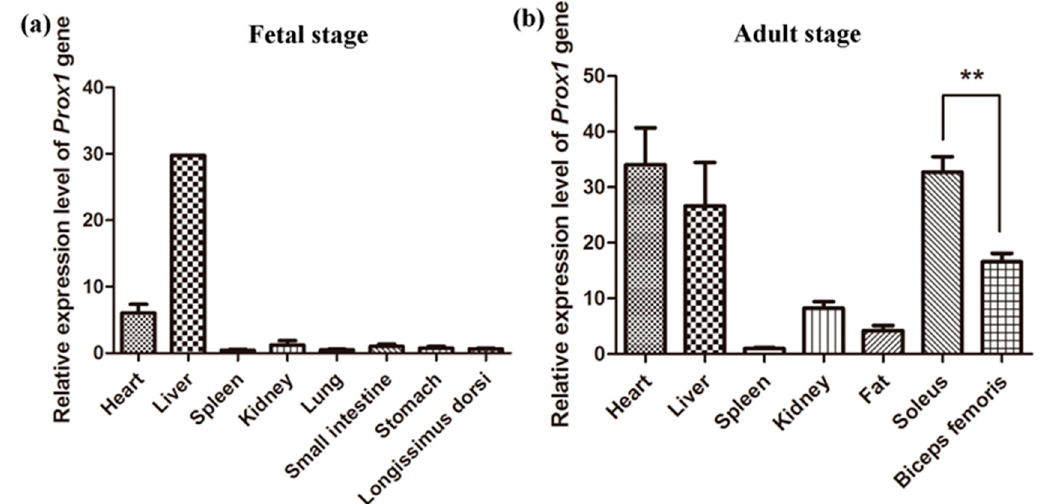
Figure 1. Expression pattern of porcine Prox1 . ( a ) Expression pattern of porcine Prox1 in fetal tissues. ( b ) Expression pattern of porcine Prox1 in adult tissues. Real-time polymerase chain reaction (PCR) was used to determine the expression levels of Prox1 genes. All PCR reactions were performed in triplicate for each sample. Relative expression levels were calculated using the 2 − △△ ct value method and normalized with the porcine housekeeping gene HPRT . Data are presented as the mean ± Standard Error of Mean (SEM) (n = 3). Statistical analysis was performed using the unpaired sample t test in SPSS 20.0. Note: ** indicates p < 0.01.